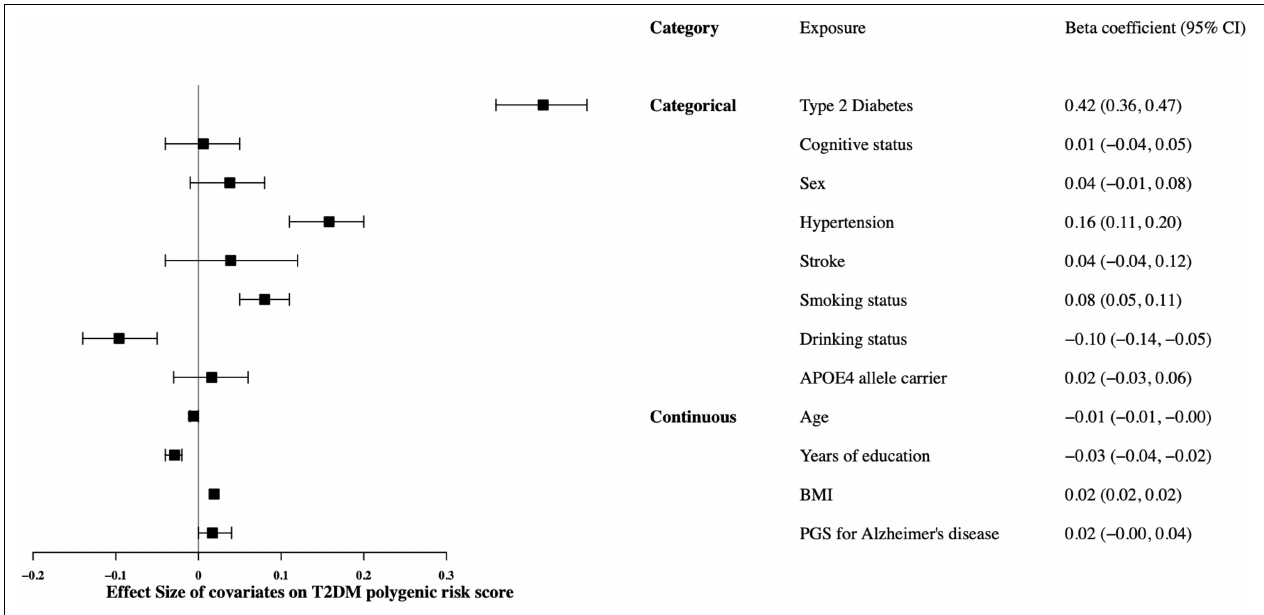
FIGURE 2 | Associations between polygenic score for Type 2 diabetes mellitus a and factors potentially confounding the relation between Type 2 diabetes mellitus and cognitive status, Health and Retirement Study, Wave 2010, European ancestry sample ( n = 8,433). APOE, Apolipoprotein E; BMI, Body Mass Index; CI, Confidence Interval; PGS, polygenic score. a The Type 2 diabetes mellitus polygenic score was created using weights from a genome-wide association study meta-analysis from the DIAbetes Genetics Replication and Meta-analysis Consortium (Morris et al., 2012) using a P -value threshold of 1. b The cognitive status was ordered as normal-CIND-dementia (0-1-2). c The smoking status was ordered as never-former-current (0-1-2). d The Alzheimer’s disease polygenic score was created using weights from a genome-wide association study meta-analysis from a 2019 GWAS by Kunkle et al. (2019) using a P -value threshold of 0.01 and removing the APOE region (chr19: 45,384,477–45,432,606, build 37/hg 19) (Ware et al., 2020).